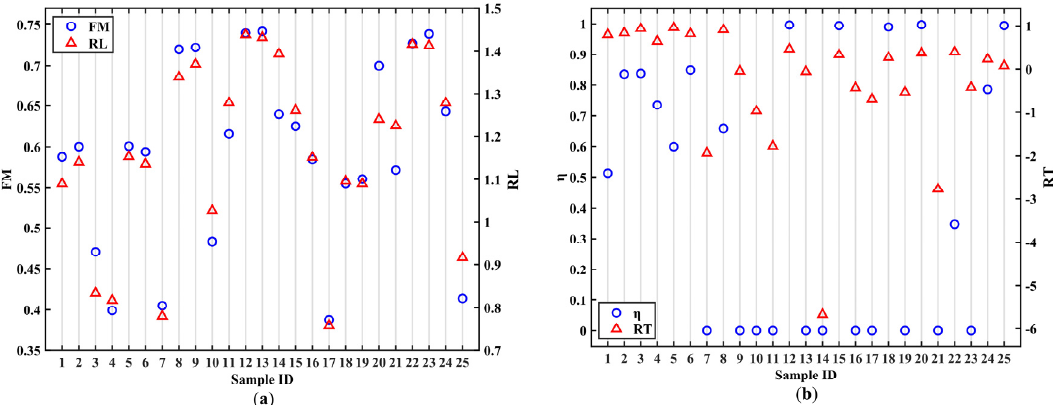
Figure 15. Aerodynamic characteristics of duct samples. ( a ) Hover flight. ( b ) Forward flight. Those results can lead to K values as shown in Figure 16, and the K values are normalized to show the quality of design variables at different levels.